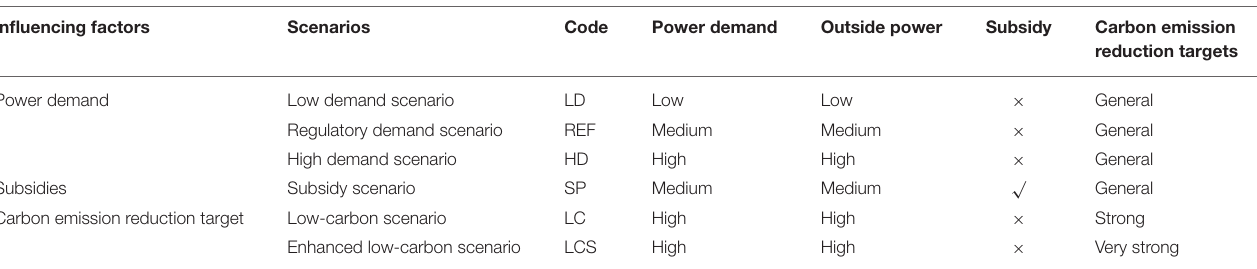
TABLE 1 | Characteristics of scenario